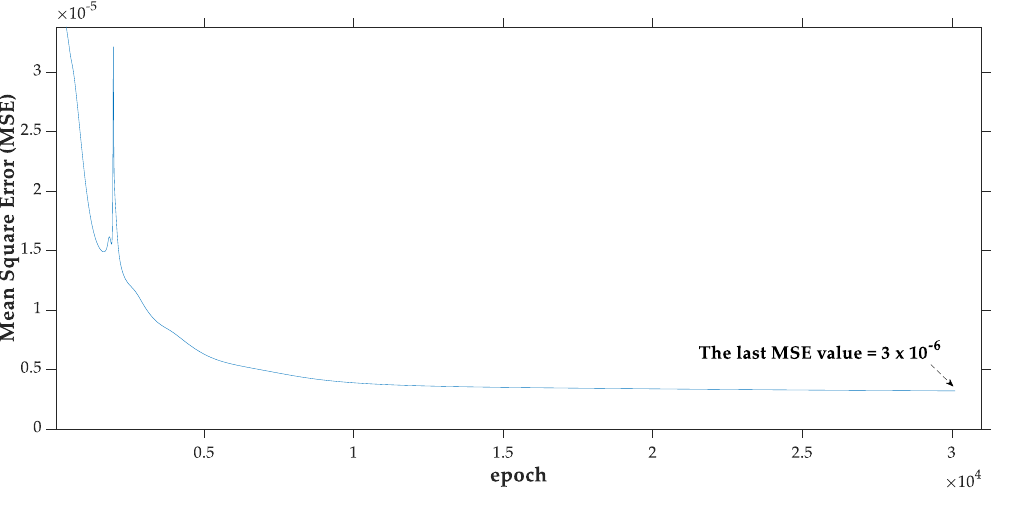
Figure 8. Mean square error performance curve.